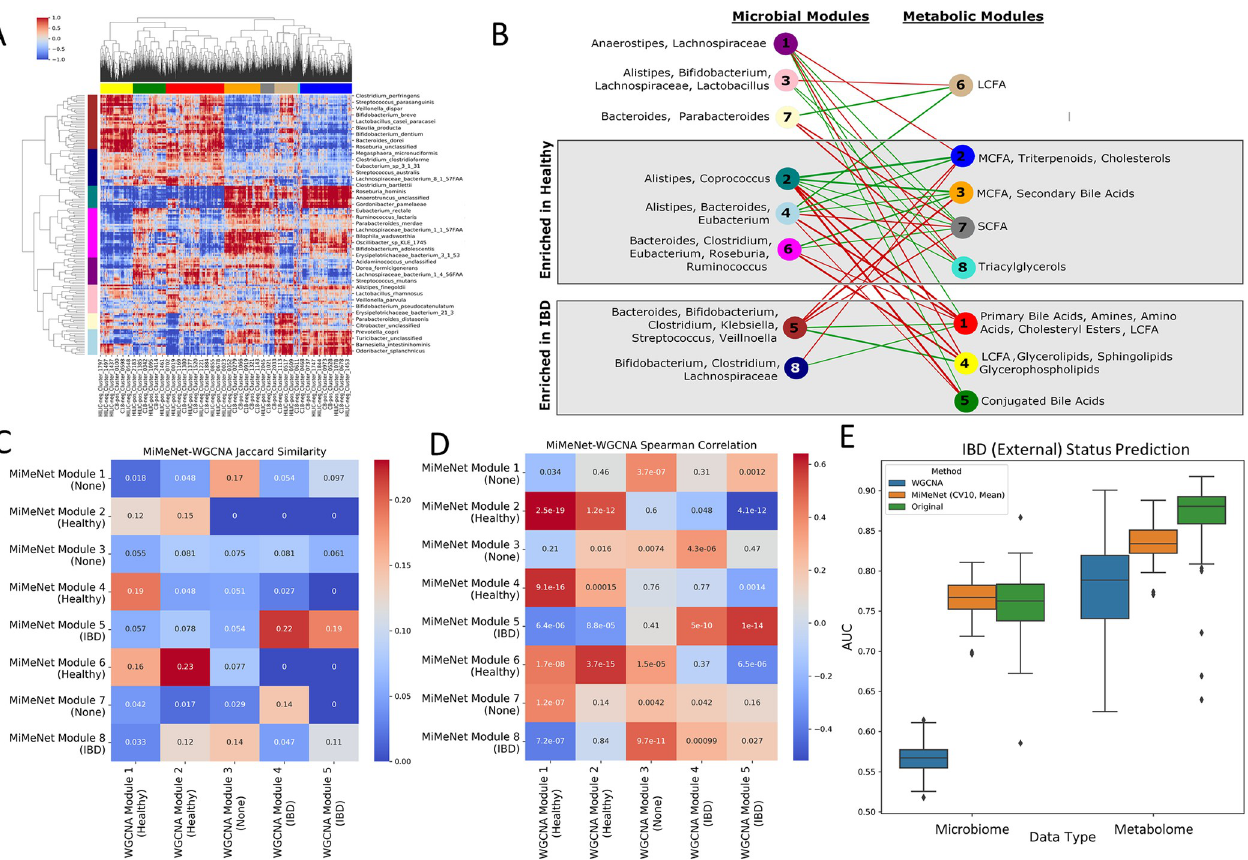
Fig 5. Clustering of microbes and metabolites in the IBD datasets. (A) Clustering of microbes (row) and metabolites (column) based on the feature attribution scores obtained from the IBD (PRISM) dataset. Row and column colors represent assigned modules. (B) Network connecting microbial modules with metabolomic modules. The most abundant genera are annotated for microbe modules. The most abundant metabolite classes are annotated for the metabolite modules. Red connections indicate negative attributions and green edges indicate positive attributions. Node color represents module color from (A). (C) Jaccard Index and (D) Spearman correlation between module features of WGCNA and MiMeNet. Jaccard Index values and Spearman correlation p- values shown in the boxes. (E) IBD status prediction of IBD (External) using models trained on WGCNA module feature values, MiMeNet module feature values, and original abundance from IBD (PRISM) microbial and metabolomic